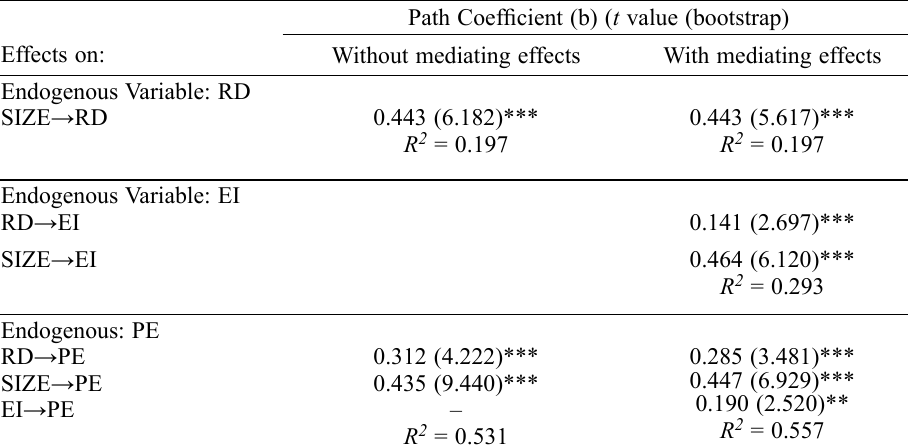
Table 2. R&D, exports and